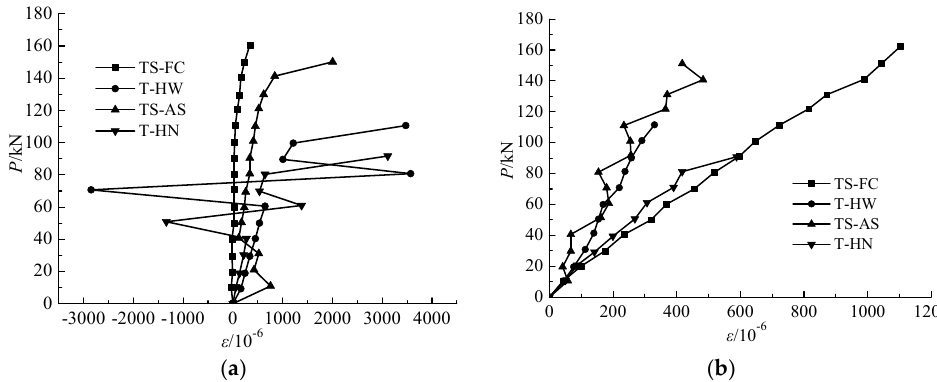
Figure 11. Total vertical loading–axial strain curves of the crown and saddle position for joints. ( a ) The crown position of joint ‘p’; ( b ) The saddle position of joint ‘n’.